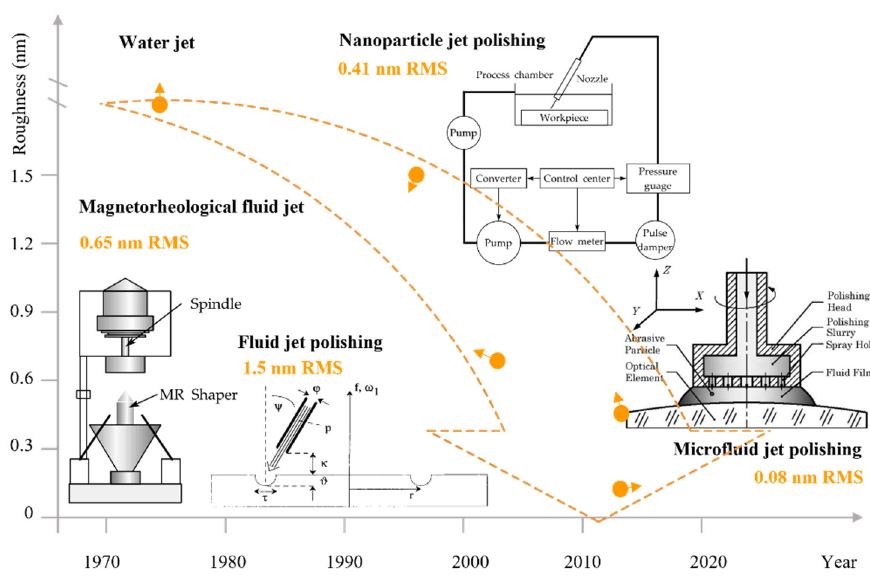
Figure 34. The historical development of FJP. Reproduced with permission from